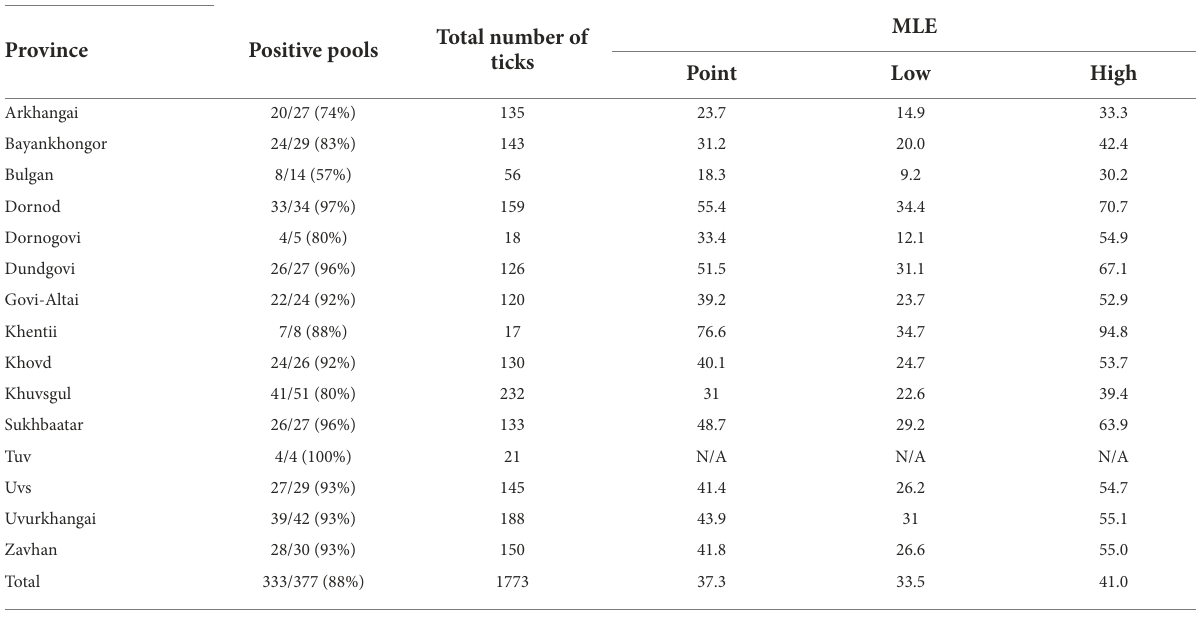
TABLE 3 Maximum likelihood estimates of Rickettsia spp. by region based on confirmatory results including 95% confidence intervals. Rickettsia spp.